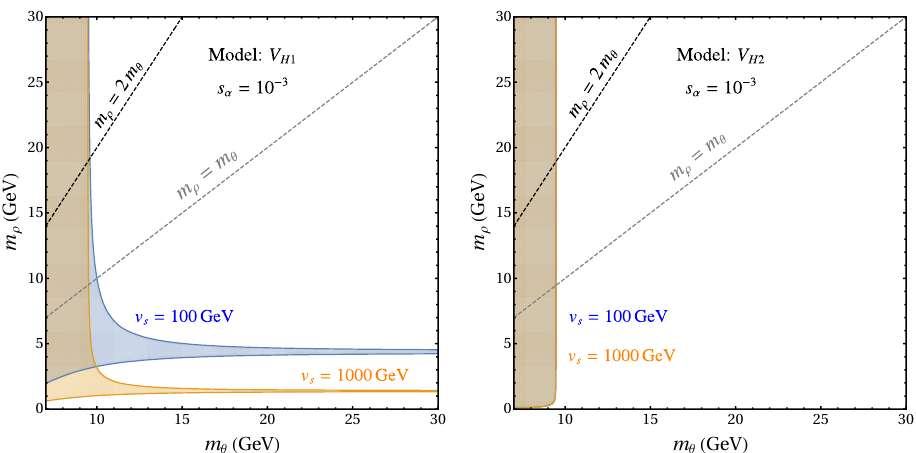
Figure 13. Parameter space that is allowed by the XENON1T bound for the models with the symmetry breaking terms in the potential V colored region corresponds to v resonance condition with the ρ ( m